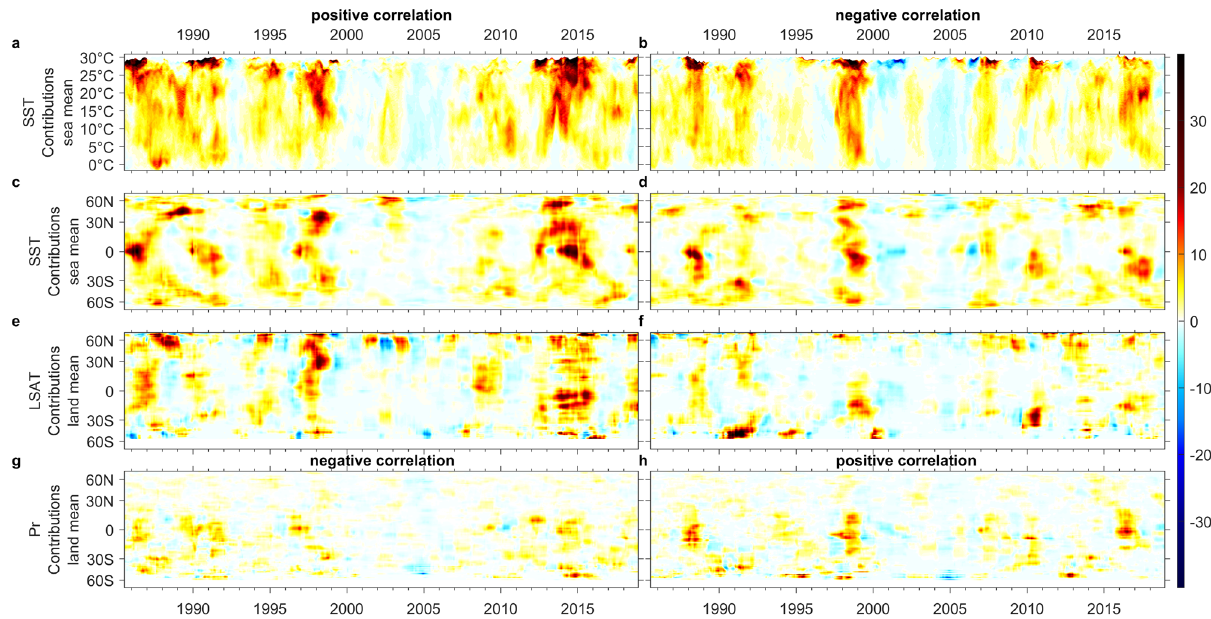
Fig. 2 Breakdown of estimated exclusive SST , LSAT , and Pr contributions to dC CH4 / dt (ppb yr − 1 ) with a positive and negative sign of n IF a (or correlation). c – h Lat x time coordinate and a , b SST x time coordinate. A positive ∂ C CH4 ( T ) / ∂ t could be a result of rising temperature with positive nIF a,T or decreasing temperature with negative nIF a,T . Similarly, a positive ∂ C CH4 ( Pr ) / ∂ t could be due to increasing precipitation with positive n IF a,Pr or decreasing precipitation with negative n IF a,Pr